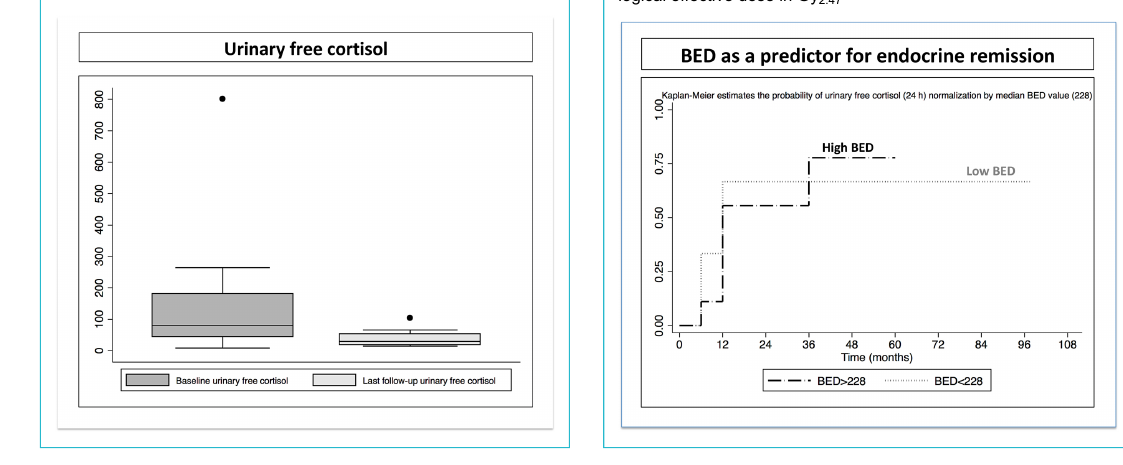
Figure 3: Probability of endocrine remission with high and low BED; the number of patients for the time-points at 12, 24, 36, 51